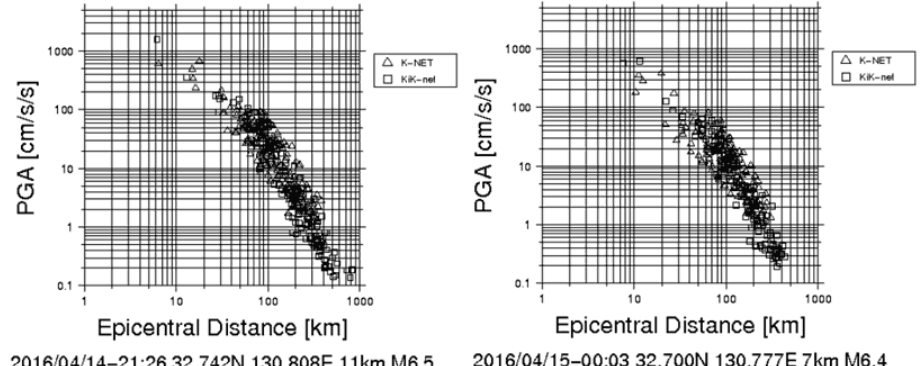
Figure 2. Attenuation trends of the recorded foreshock events on 14 and 15 April 2016.